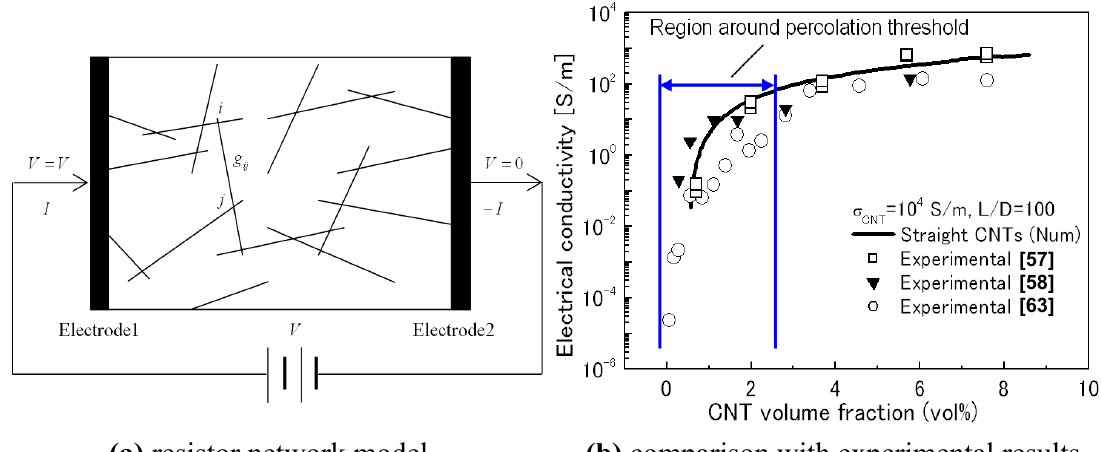
Figure 8. Resistor network model and comparison between numerical results and experimental